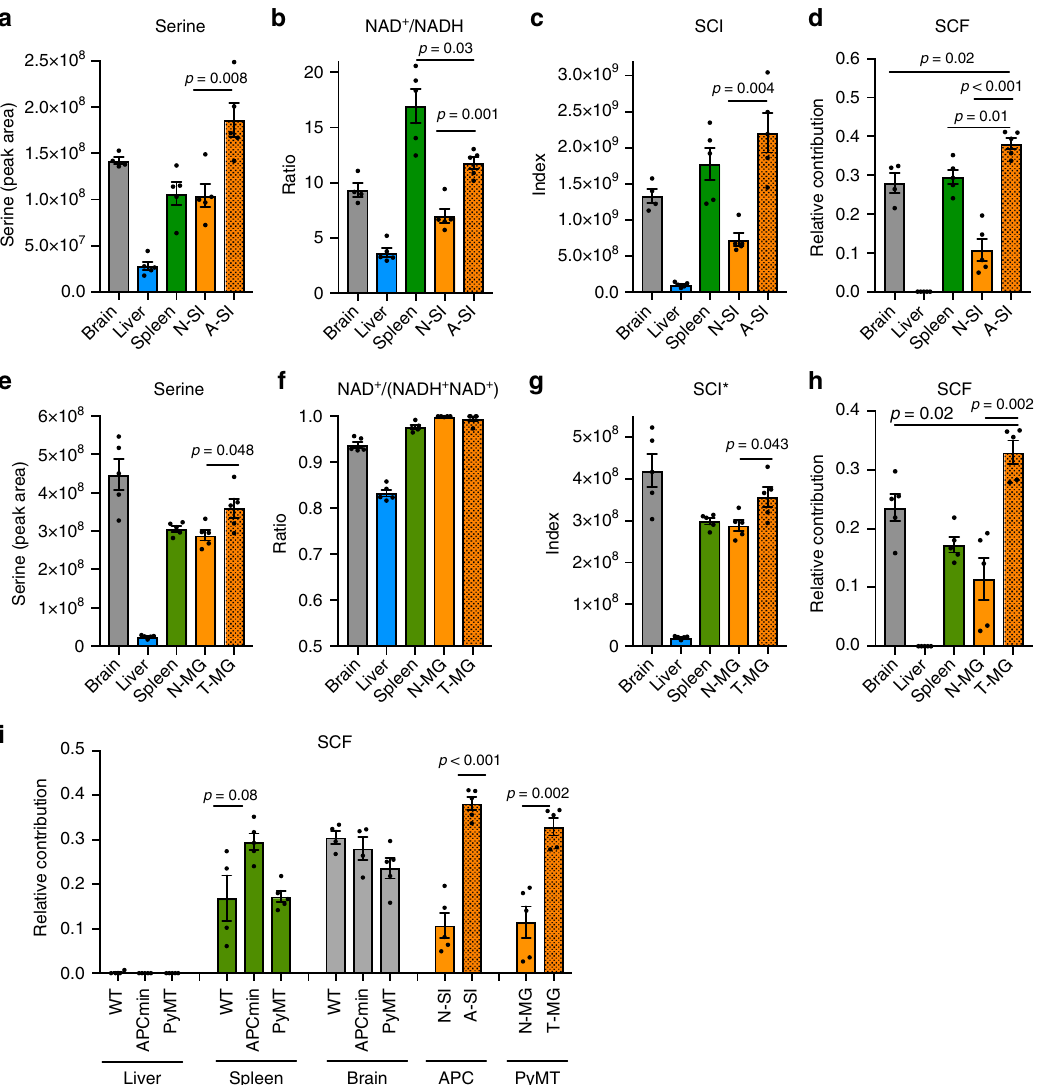
Fig. 4 Increased serine catabolism to formate in APC Min/ + adenomas and PyMT tumors. a – d Metabolic analysis of APC Min/ + mice with clinical manifestation of the disease. a Serine levels, b NAD + /NADH ratio c SCI and d SCF in brain, liver, spleen, normal small intestine (N-SI), and in small intestine adenomas (A-SI) 24 h after 13 C – MeOH injection. e – h Metabolic analysis in PyMT tumor-bearing mice (as in a – d ). Except for f : here the NAD + /(NADH + NAD + ) ratio was assessed due to technical reasons. g *Accordingly, in this case the SCI was calculated by serine × NAD + /(NADH + NAD + ). MG mammary gland, T tumor, N normal. i Comparison of SCF in liver, spleen and brain in WT, APC Min/ + , and PyMT mice and SI and MG tissues. Results were obtained from at least three mice. Error bars denote s.e.m. p -values are calculated using an unpaired t -test with Welch ’ s